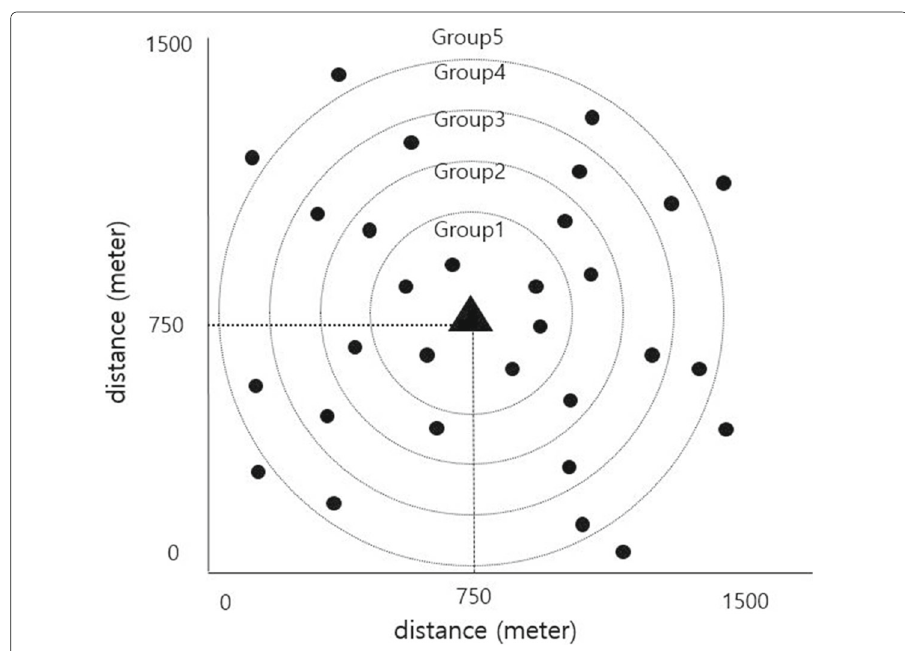
Fig. 7 LoRa terminal node